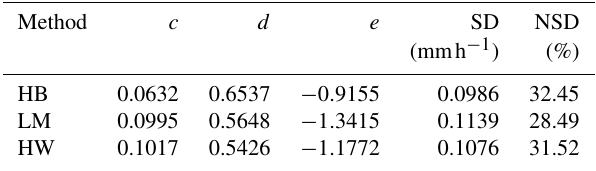
Table 4. Coefficients and exponents of the SR( Z Ku ,DWR) relation (see Eq. 10) for three